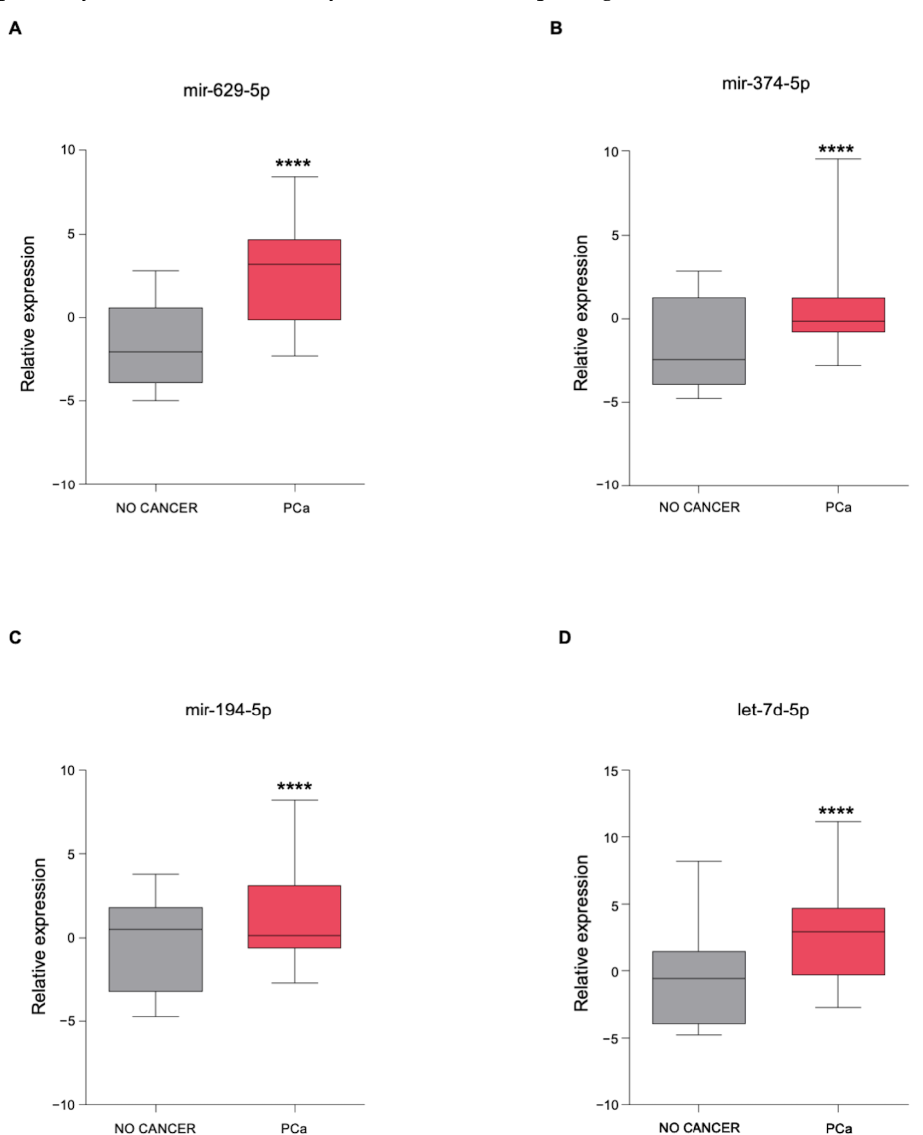
Figure 4. Expression levels of the newly identified miRNAs in the serum from PCa patients. ( A – D ) Boxplot showing the expression of ( A ) mir-629-5p, ( B ) mir-374-5p, ( C ) mir-194-5p, and ( D ) let- 7d-5p in the serum from control healthy volunteers ( n = 41) and human PCa patients ( n = 809) reported in the GSE112264 dataset. Shown in the boxplot are the medians (horizontal lines), 25th–75th per- centiles (box outlines), and the highest and lowest values within 1.5 × of the inter-quartile range (vertical lines). Statistical significance was calculated by using the two-tailed Mann–Whitney U-test. ** p -value < 0.01, **** p -value <